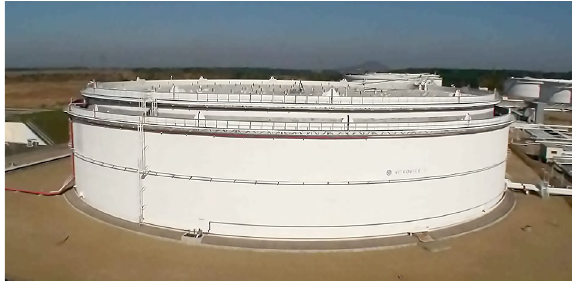
Fig. 1. Welded tank for oil